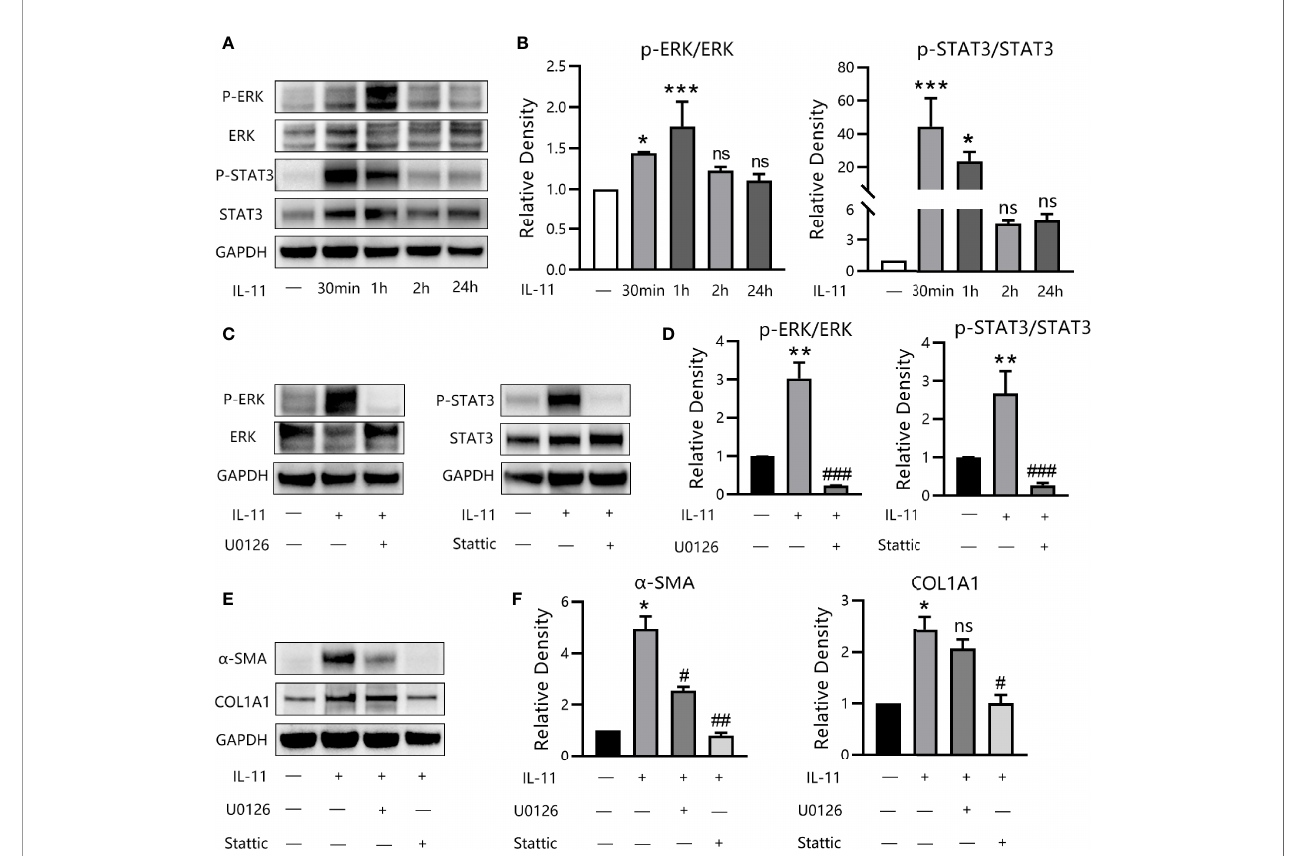
FIGURE 6 | IL-11 drives fi brogenic protein synthesis via ERK and STAT3 pathways. (A) Western blots assessing protein levels of p-ERK, ERK, p-STAT3, STAT3, GAPDH in thyroid-associated ophthalmopathy (TAO) orbital fi broblasts (OFs) with the stimulation of IL-11 (10 ng/mL) for 30 min, 60 min, 2 h or 24 h (n = 3). (B) The protein levelswere quanti fi edand analyzed. The data are expressed as the mean ± standard deviation (SD). ***P < 0.001, *P < 0.05 compared with the control;nsdenotes no statistical signi fi cance versus the control; assessed byTukey ’ s corrected one-way analysis of variance. (C) Westernblots of p-ERK, ERK,p-STAT3, STAT3, GAPDH in TAO OFsfollowingstimulation with IL-11 (10 ng/mL,1 h) with or without a 2-h pretreatment with U0126 (10 m M)orStattic(10 m M) (n= 3). (D) The protein levelswere quanti fi ed and analyzed. (E) Western blot of a -SMA, COL1A1, and GAPDHexpression inTAO OFs under IL-11 (10 ng/mL,48 h)stimulation with orwithout a 2-h pretreatment with U0126 (10 m M)orStattic(10 m M) (n= 4). (F) The protein levelswere quanti fi ed and analyzed.Data are expressed as mean ± SD. **P < 0.01, *P < 0.05 compared with the control; ### P < 0.001, ## P < 0.01, # P < 0.05 compared with IL-11 alone; nsdenotes nostatisticalsigni fi cance versusIL-11; assessed by Tukey ’ s corrected one-way